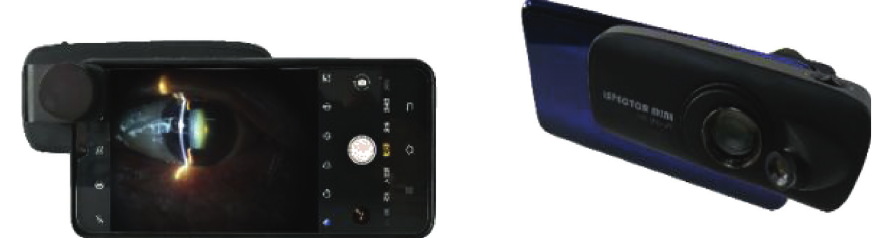
Figure 2: Smartphone slit-lamp installed on a smartphone.